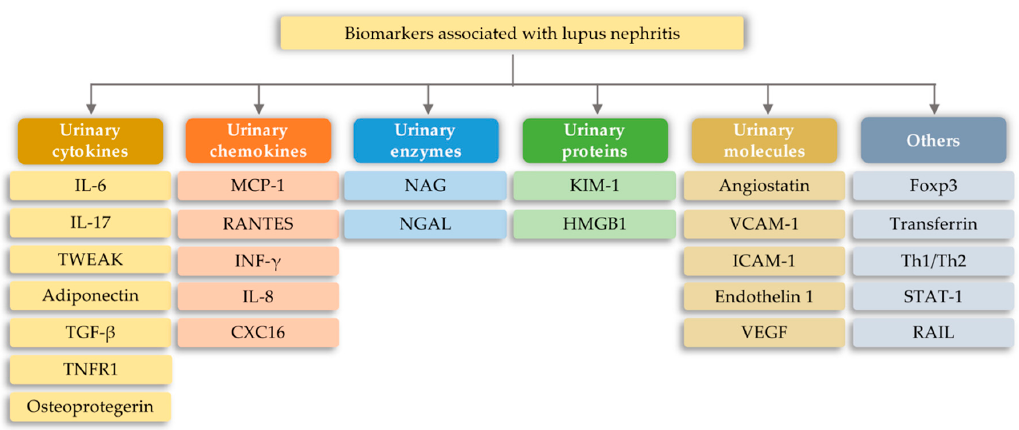
Figure 7. Biomarkers associated with lupus nephritis [128]; CXC16—C-X-C motif chemokine 16;